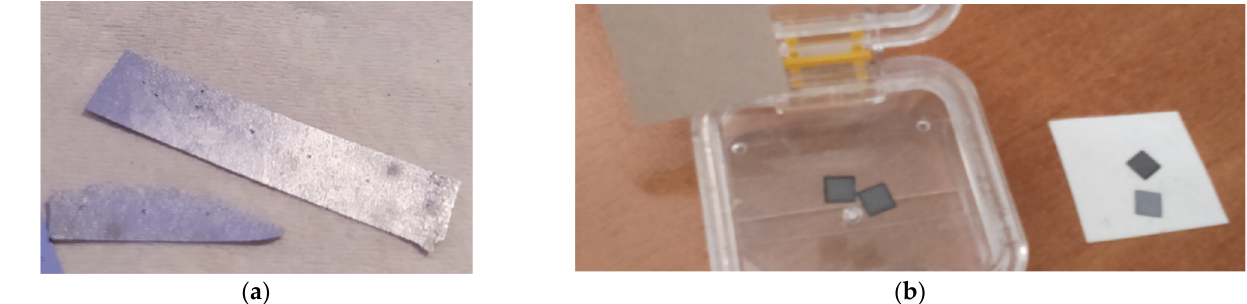
Figure 5. ( a ) An example of a thin diamond film grown on silicon. After the thinning of the silicon wafer up to a thickness of about 80 μ m, substrate bending is clearly evidenced. ( b ) 5 mm × 5 mm diamond on 120 μ m thick silicon plates after membrane fabrication.